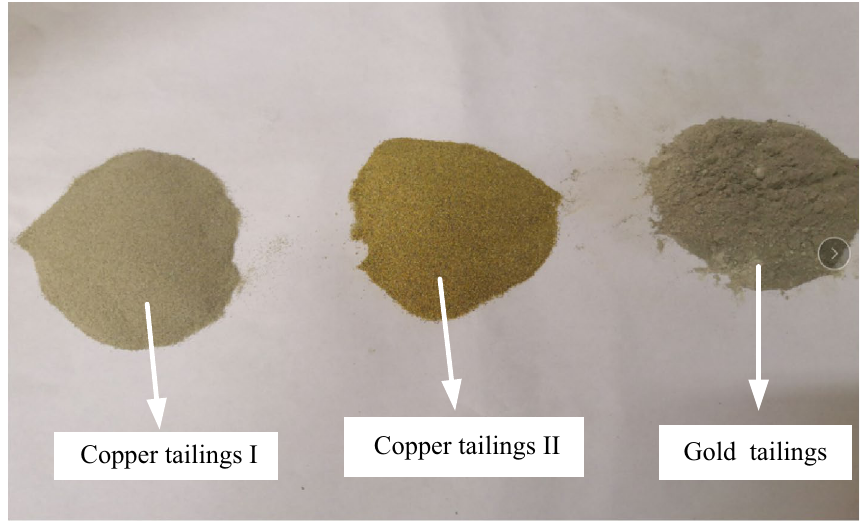
Figure 1. Original tailings